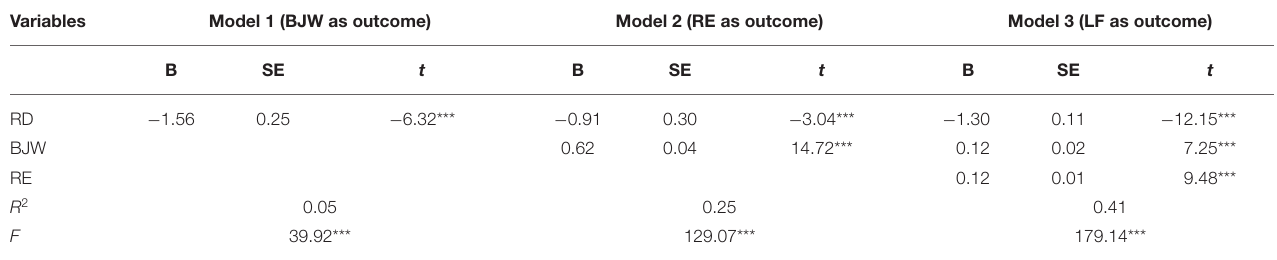
TABLE 2 | Model results.